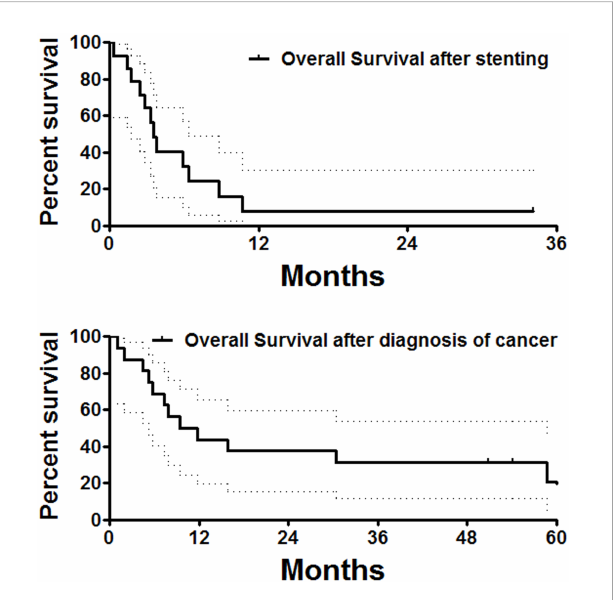
FIGURE 4 Overall survival follow-up. The median overall survival calculated from stent placement or diagnosis of the esophageal cancer was 3.5 and 10.6 months,